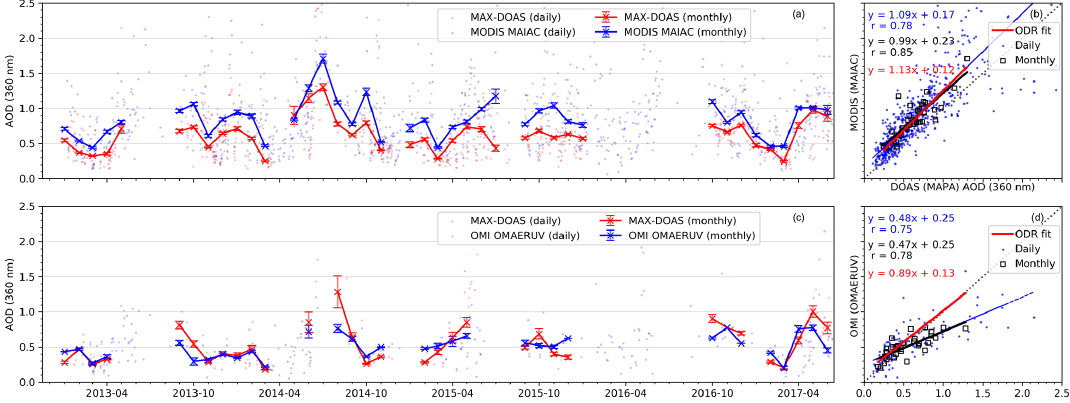
Figure 7. Intercomparison of daily (dots) and monthly mean (lines and markers) AOD at 360nm retrieved from ground-based MAX-DOAS measurements and from the MODIS MAIAC data product (a, b) and OMI AERUV data product (c, d) . The monthly mean of the MAX- DOAS and satellite data products were calculated by considering only the days of the month when both the measurements were available, causing different MAX-DOAS monthly means in (a) and (c)